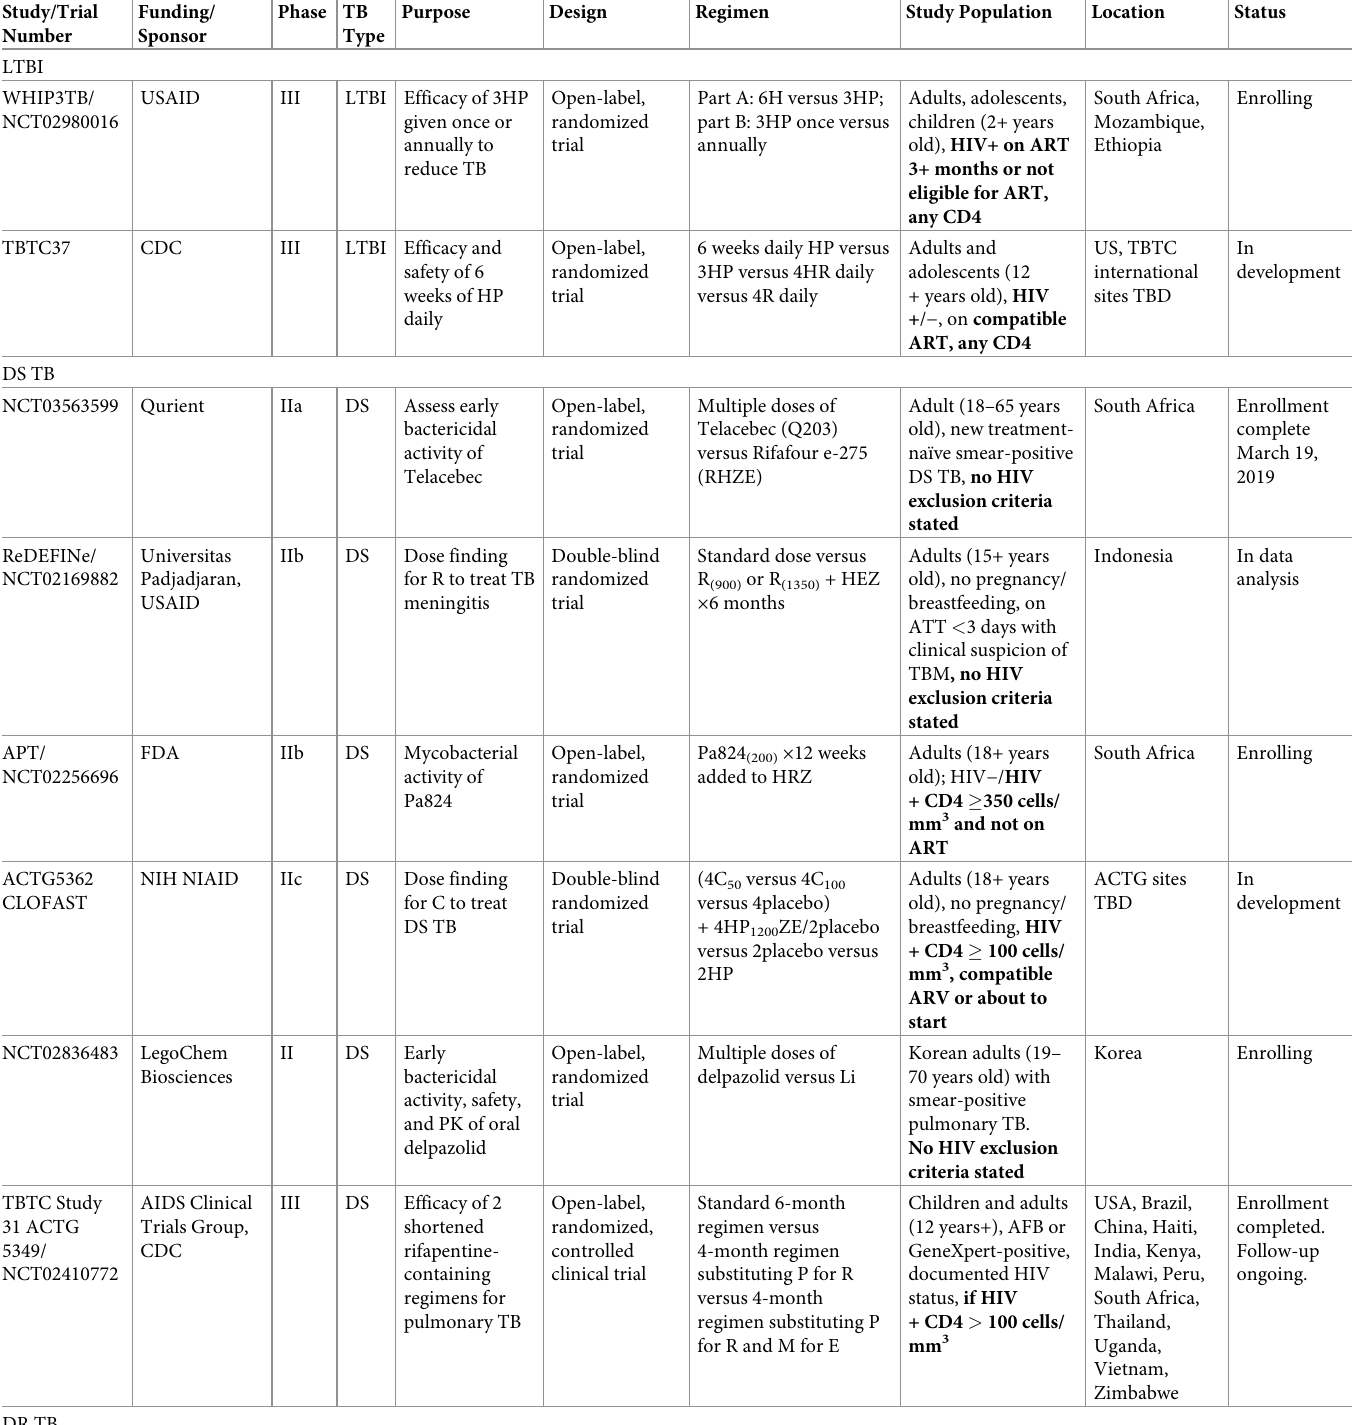
Table 4. Ongoing and planned TB clinical trials in HIV-infected persons 12 years and older (as of December